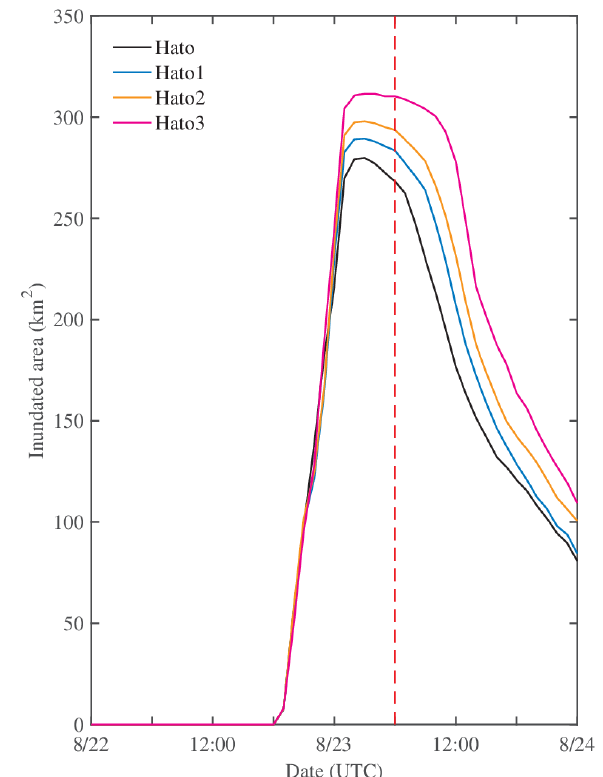
Figure 10. Time series of simulated inundation area (units: km 2 ) generated by di ff erent moving speed of typhoon center. The red “—-” marks the time of typhoon landing at 04:50 UTC on 23 August 2017. The inundation area induced by Typhoon Hato (2017), Hato1, Hato2, and Hato3 are marked with black curve, blue curve, orange curve, and pink curve, respectively. 384 The curves of variations in the inundation area form a parabola that opens downward (Figure 385 10). According to the position of the dotted line in Figure 10, during typhoon processes, the 386 inundation area reaches the peak value (and the last for a while) before the typhoon lands, but it 387 gradually decreases after the typhoon lands. By comparing the size of the downward opening 388 curves, we conclude that the slower the speed of the typhoon’s center, the longer the inundation 389 duration. Therefore, Hato3 has the longest inundation duration of the four typhoons (Hato, Hato1, 390